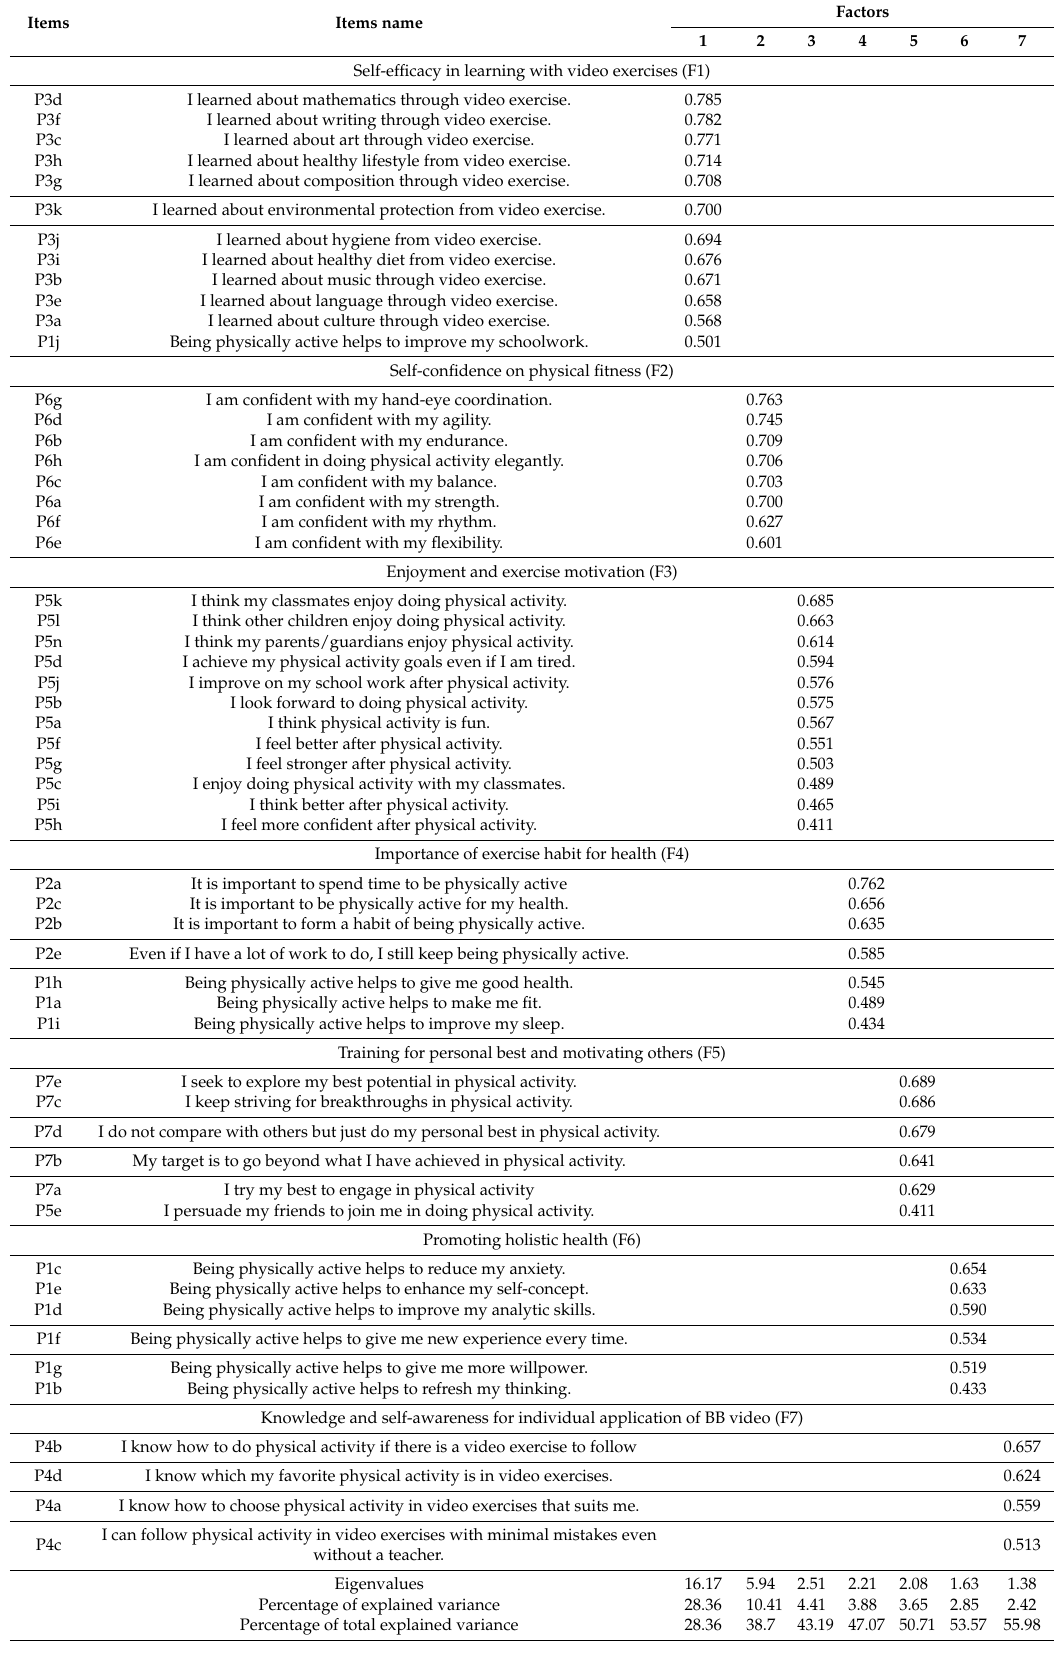
Table 2. Factor structure of